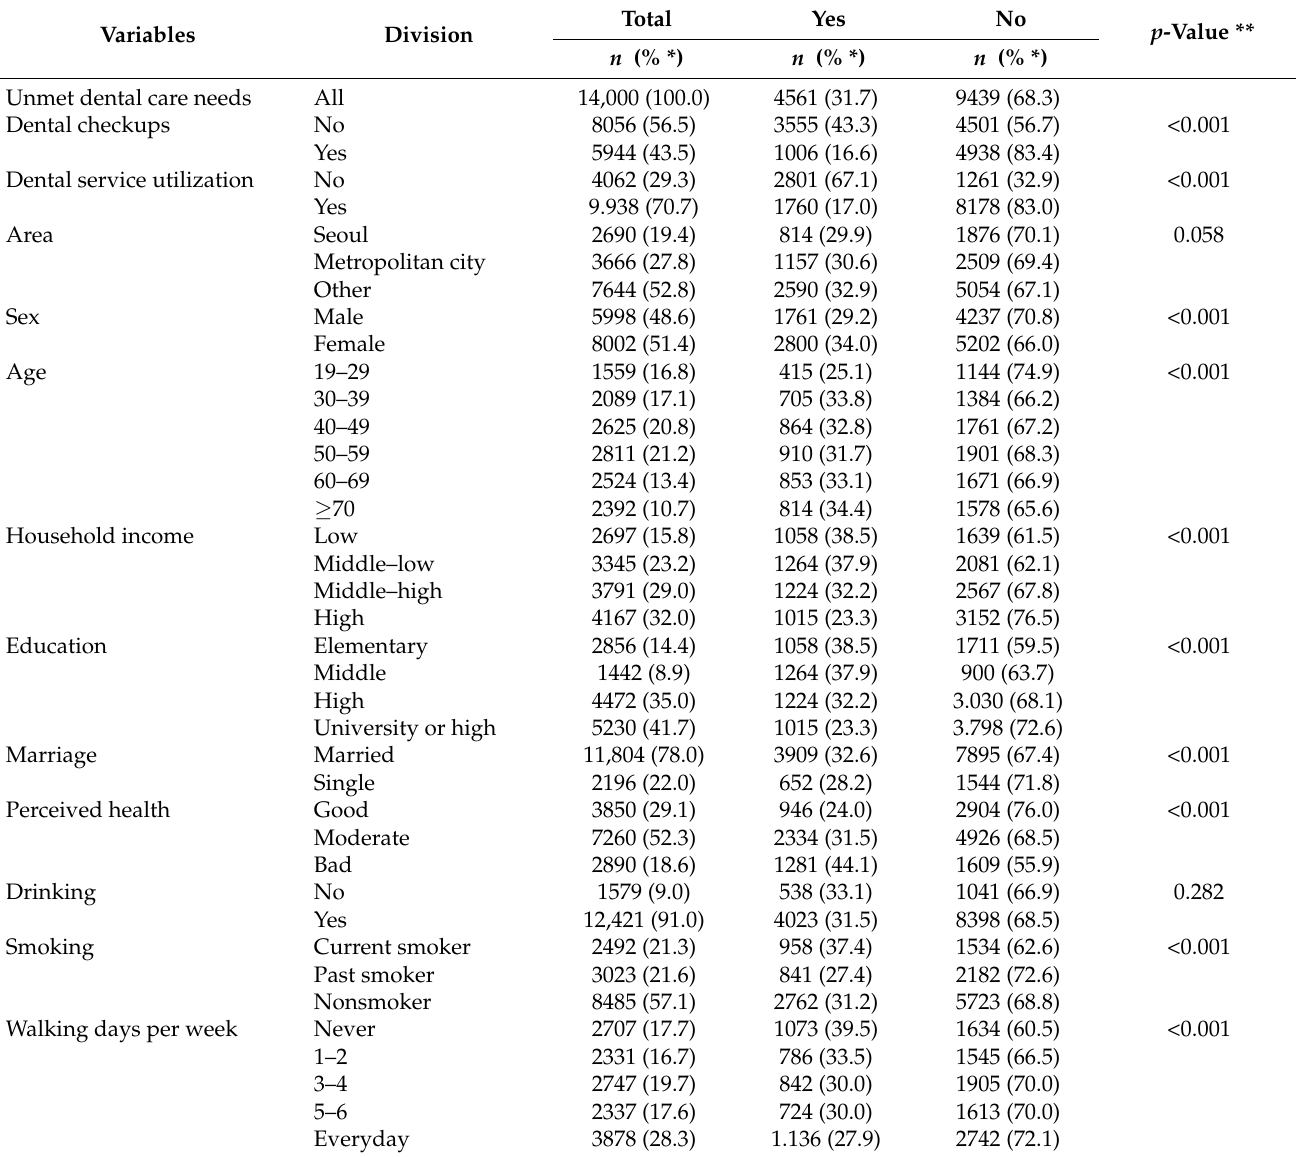
Table 1. Unmet dental care needs according to general characteristics of